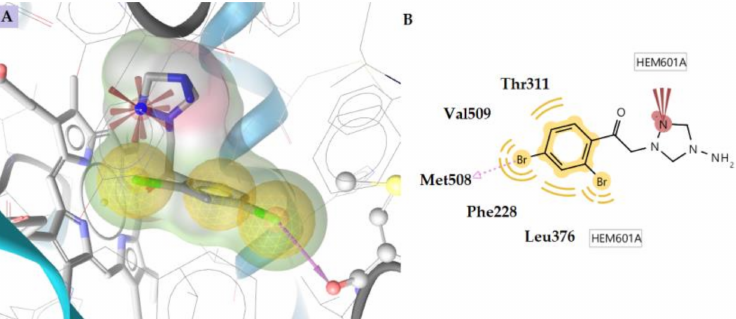
Figure 5. Docking pose of the compound 8 ( A ) and 2D diagram ( B ) in lanosterol 14 α -demethylase of C . albicans (CYP51 ca ). Pink-dotted arrows indicate halogen-bond interaction; the red arrows indicate negatively